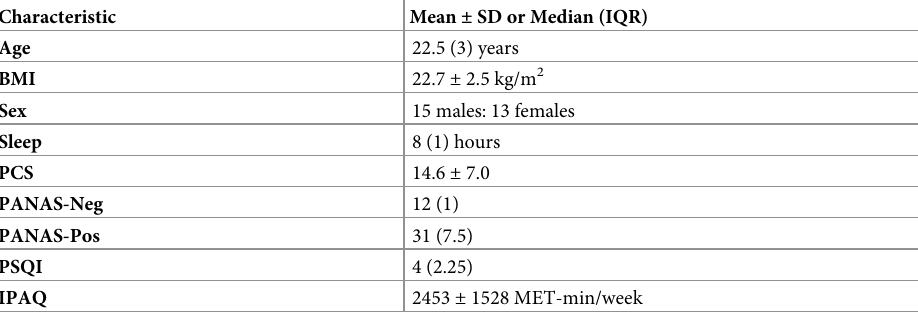
Table 1. Participant characteristics and questionnaire responses on